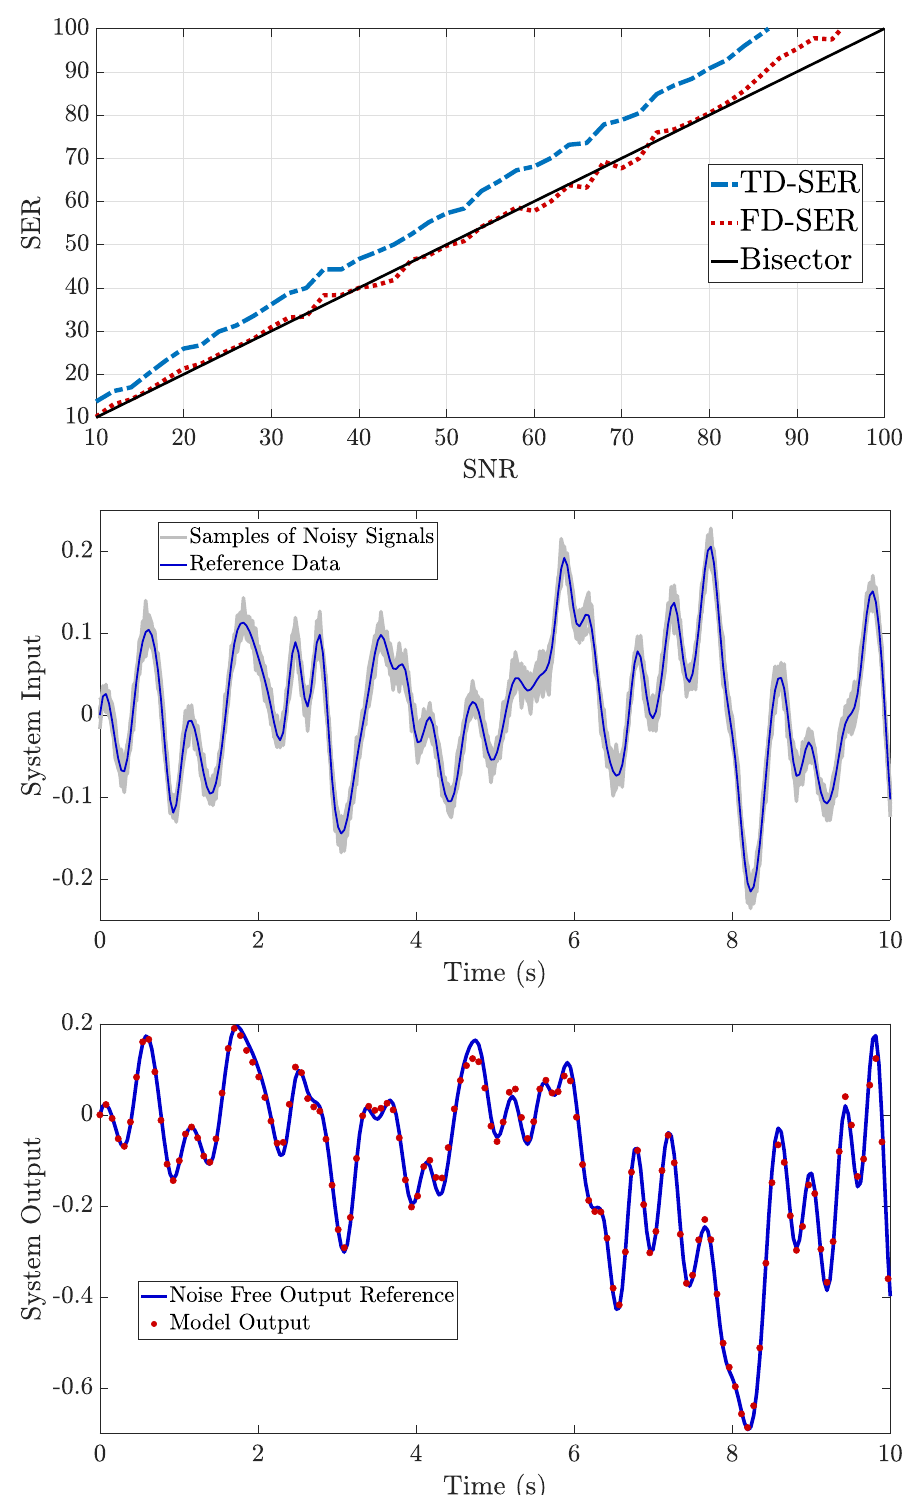
Figure 2. Top panel: the trend of TD-SER and FD-SER against the SNR. Middle panel: corrupting one training input signal (solid line) with SNR = 16 (a cloud of R = 50 different realizations are depicted in a grey shade). Bottom panel: response of a time domain model extracted from one noisy data realization (SNR = 16) compared to the reference noise-free